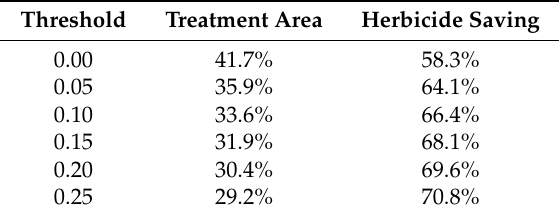
Figure 6. The accuracy curve with different weed thresholds. Table 5. Herbicide saving with different weed thresholds.